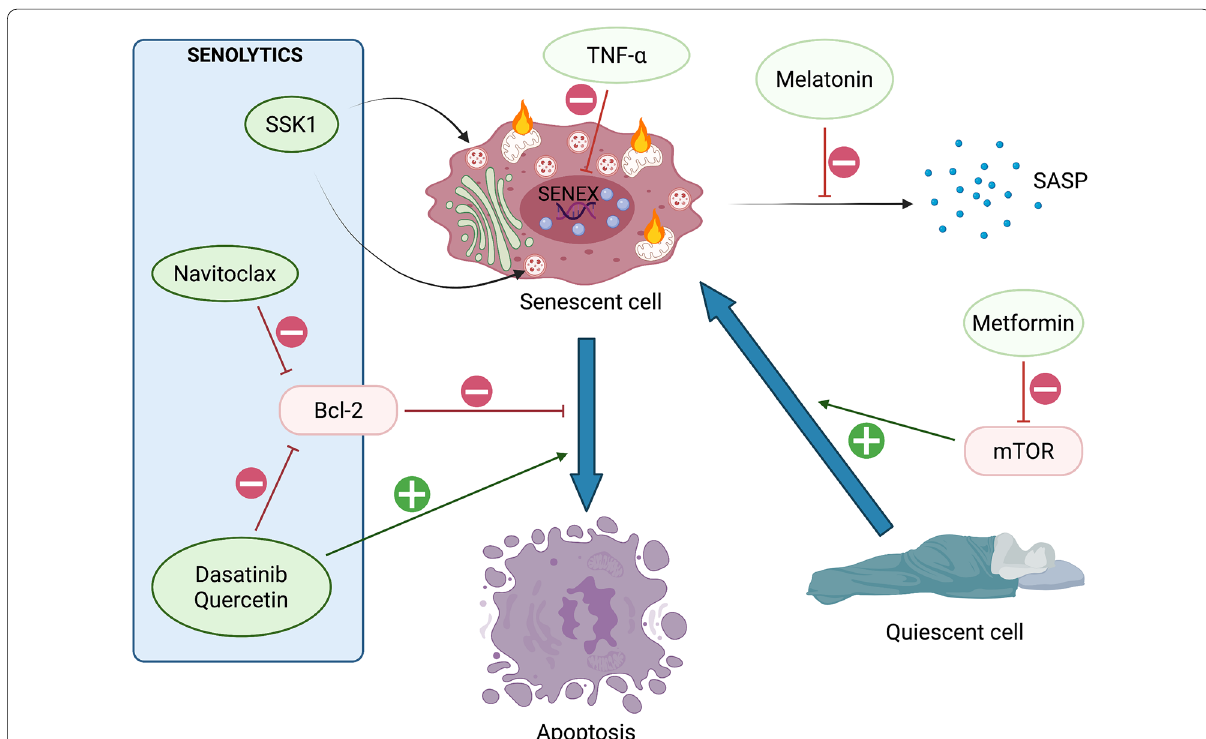
Fig. 6 Main senotherapeutic drug targets. Senolytics aiming to eliminate senescent cells favor downstream apoptosis or directly target senescent lysosomes (SSK1). Senostatics preventing the acquisition of a senescent state limit the conversion of quiescent cells, the progressive acquisition of SASP and the inhibition of SENEX. SASP senescence‑associated secretory phenotype, SSK1 senescence‑specific killing compound